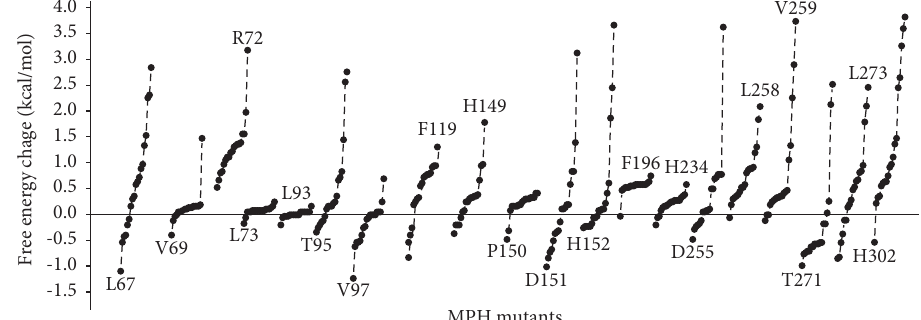
Figure 2: The changes in binding free energy of MPH virtual mutants. Each selected amino acid residue of MPH was replaced with the rest 19 residues, and the resulted MPH virtual mutants were subjected to docking analysis with methyl-parathion. The change in binding free energy of the corresponding enzyme-substrate complex was calculated by Discovery Studio. Each virtual mutant at a certain position was indicated by a bold dot, which was arranged according to its ΔΔ G bind value. To differentiate the positions of each mutation, the virtual mutants at the same position were connected by one dashed